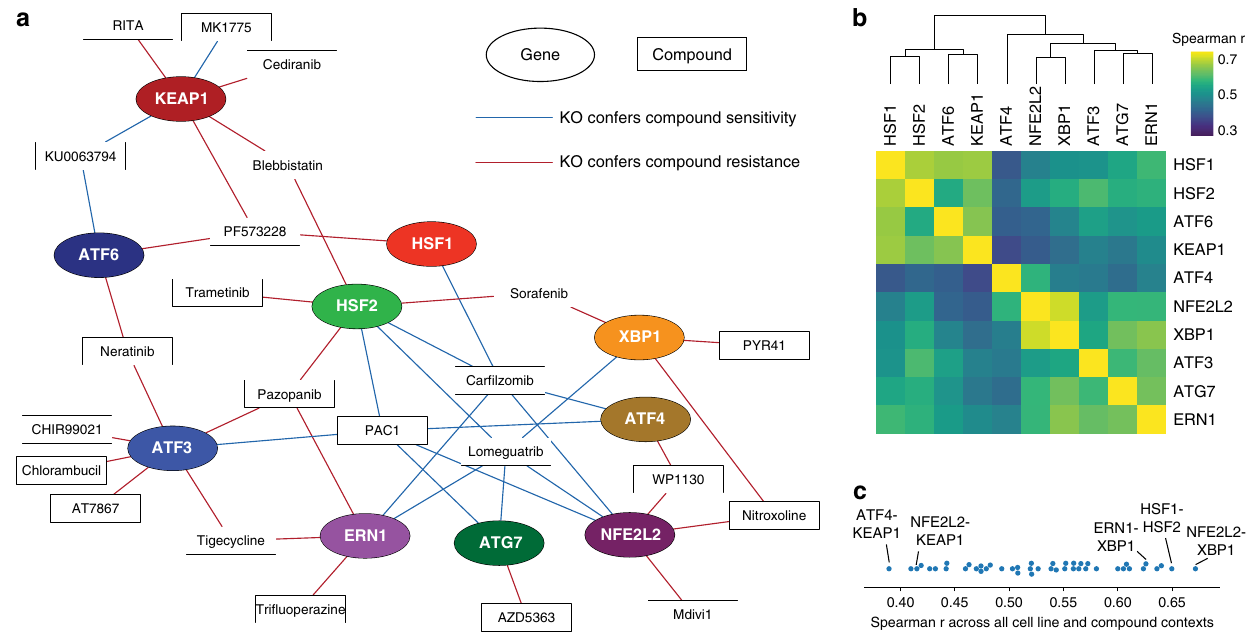
Fig. 4 QMAP-Seq enables proteostasis network mapping in breast cancer. a Chemical – genetic interaction map displaying the highest con fi dence interactions identi fi ed by QMAP-Seq (absolute AUC difference >60 and P < 0.05). Genes are represented as oval nodes, and compounds are represented as rectangular nodes. Chemical – genetic interactions where the knockout confers compound sensitivity (i.e., synthetic lethal interactions) are represented as blue edges. Chemical – genetic interactions where the knockout confers compound resistance (i.e., synthetic rescue interactions) are represented as red edges. b Spearman correlation matrix of gene – gene correlations based on AUC differences across all cell lines and compound contexts ( n = 488 cell line- compound combinations). c Distribution of gene – gene Spearman correlations across all cell line and compound contexts. Known and previously unknown genetic relationships are